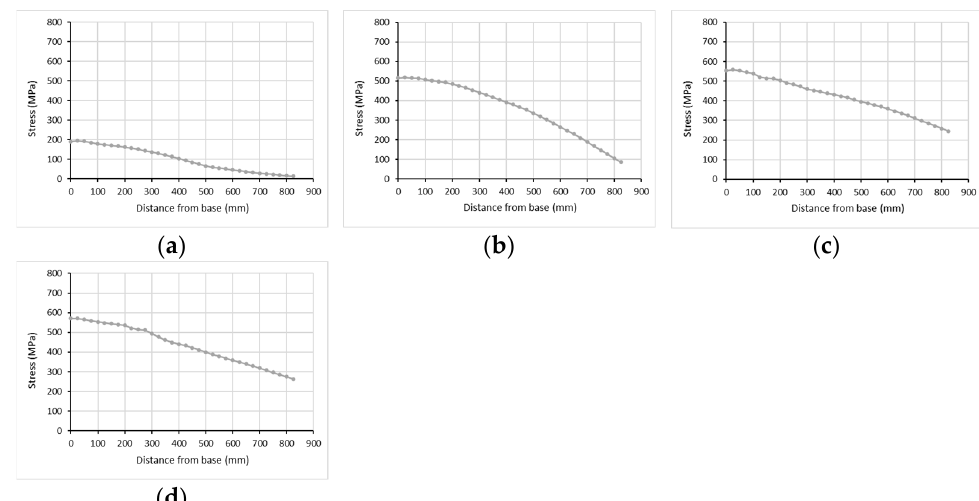
Figure 10. Predicted steel stress distribution on starter and main bar, for ( a ) monotonic analysis, and ( b ) cyclic analysis (based on results by [108]).